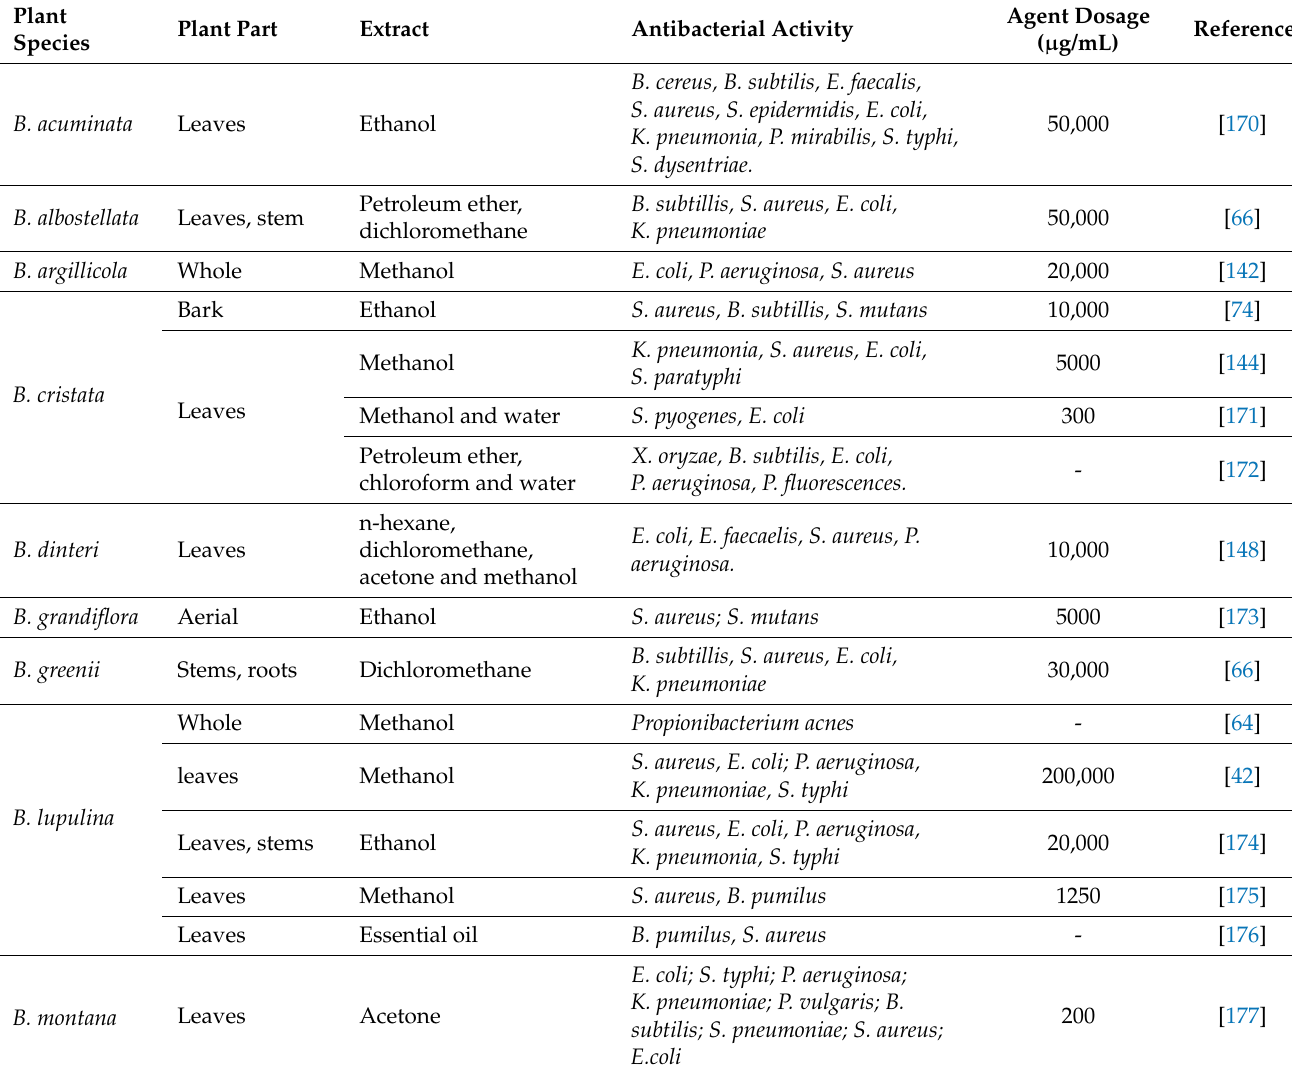
Table 3. Antibacterial activities of extracts from species within Barleria